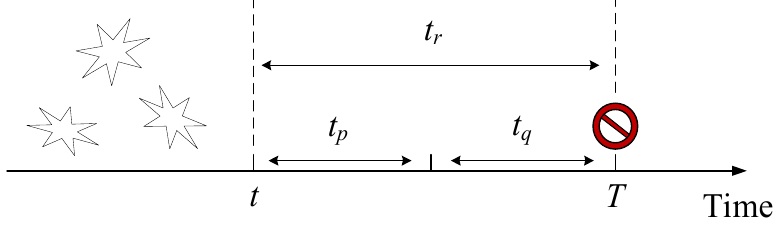
Figure 9. Schematic diagram of early warning time.